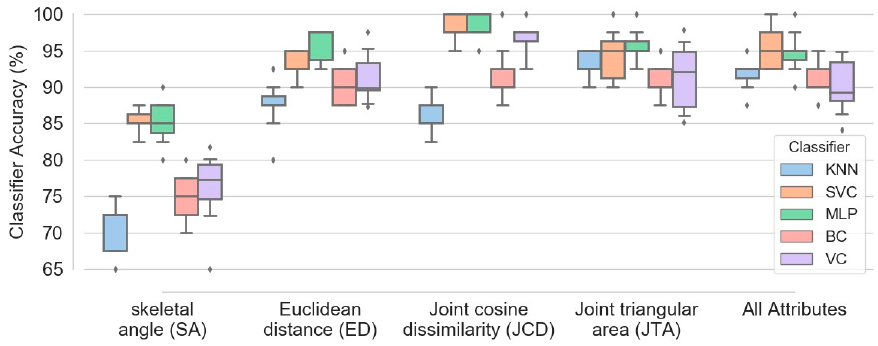
Figure 11. Box plots of different classifiers accuracy obtained based on five configurations of at- tributes, namely SA, ED, JCD, JTA and combination of all four attribute